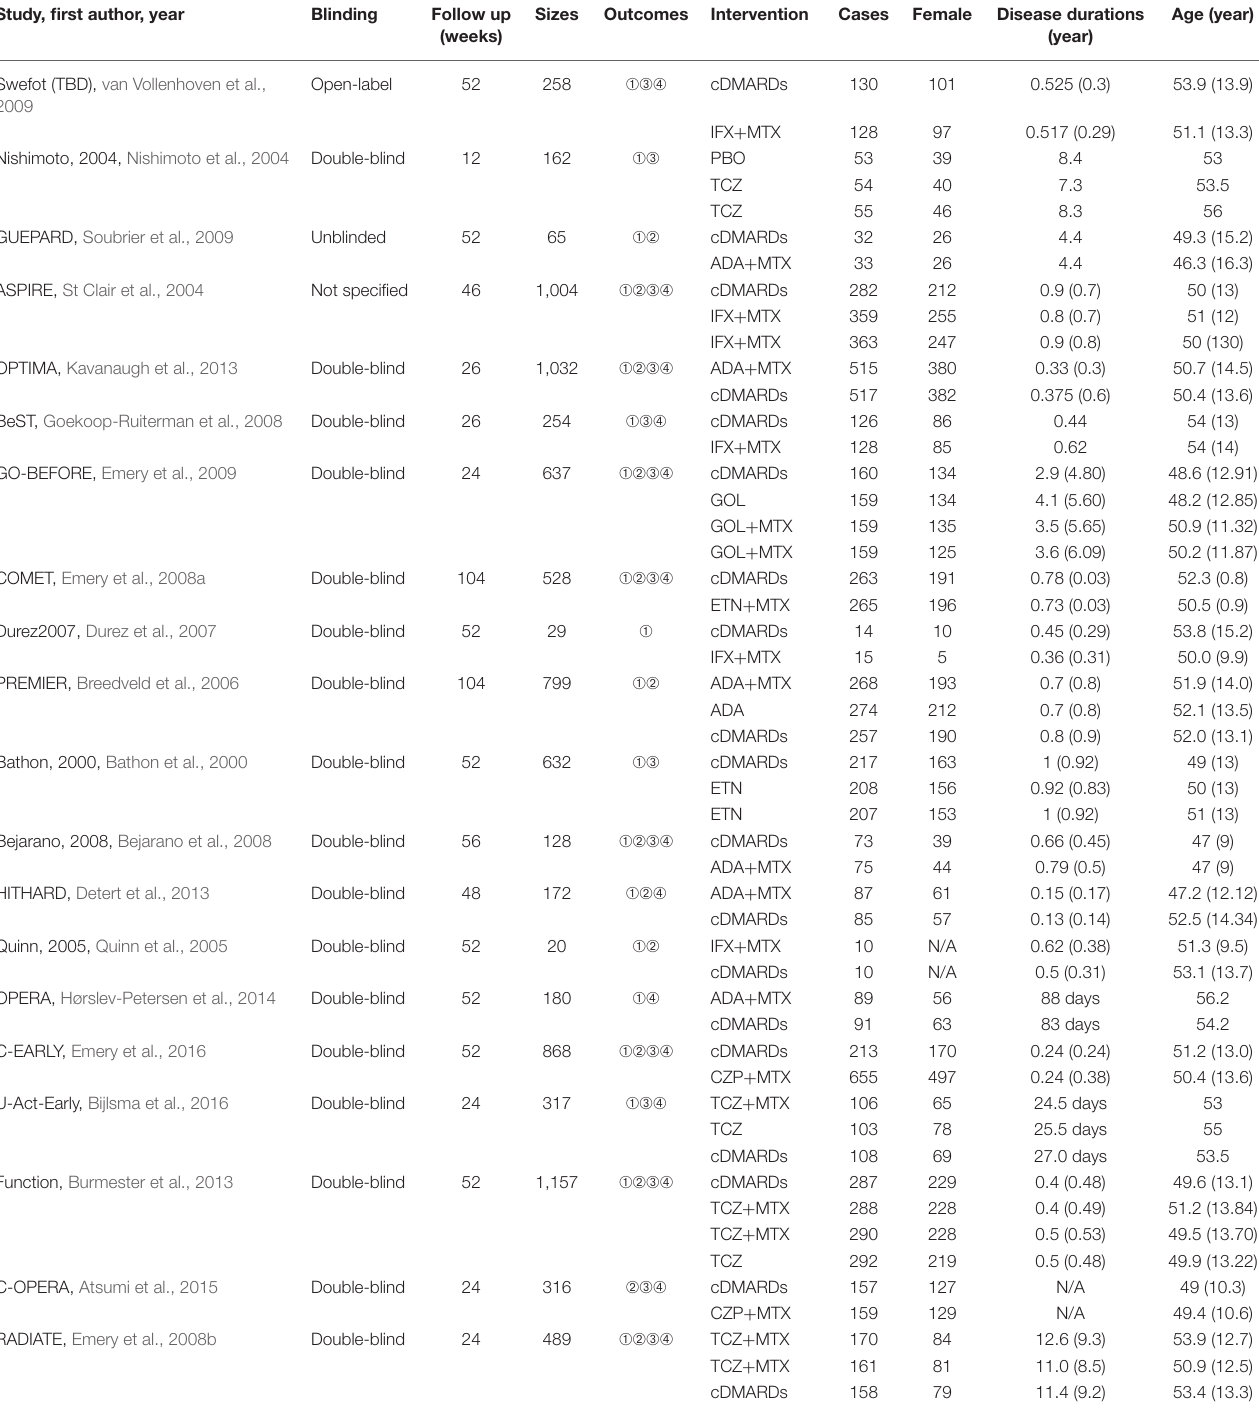
TABLE 1 | Patient characteristics in the studies included in the